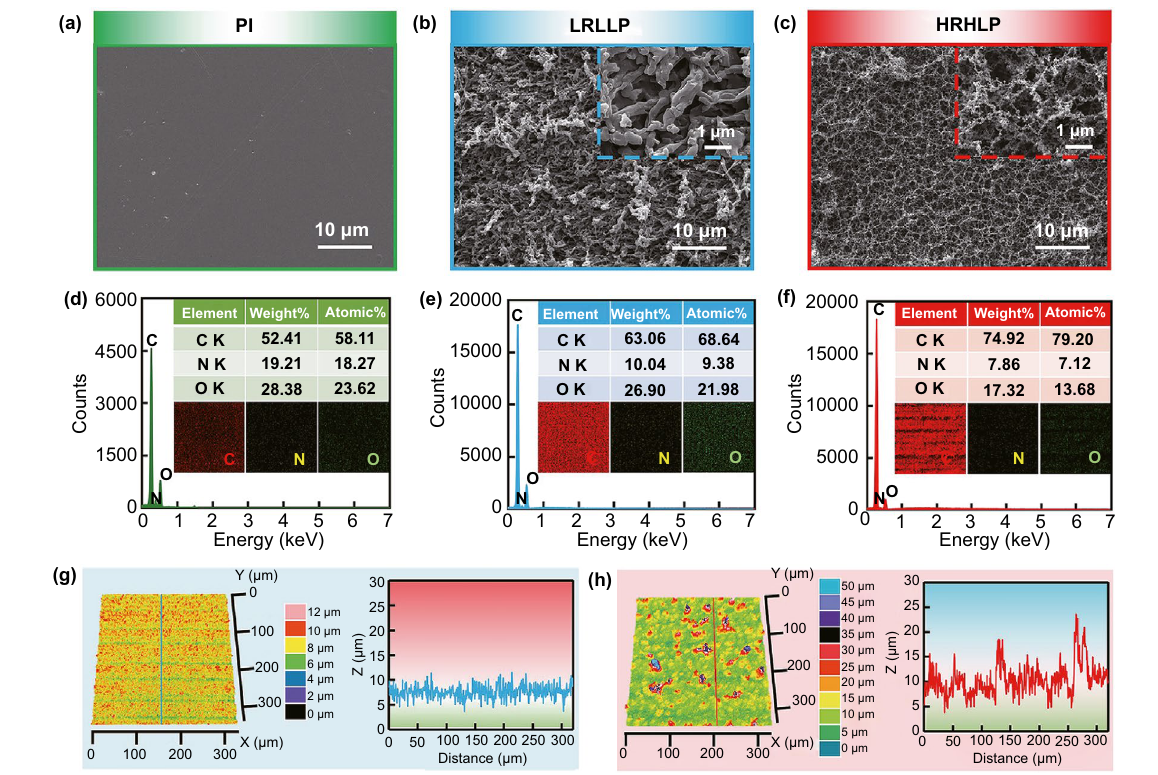
Fig. 2 SEM images of a PI, b LRLLP, and c HRHLP film surfaces. Elemental chemical composition and maps of C, N, and O for d PI, e LRLLP, and f HRHLP film surfaces. 3D morphology and cross-sectional profiles for g LRLLP, and h HRHLP film